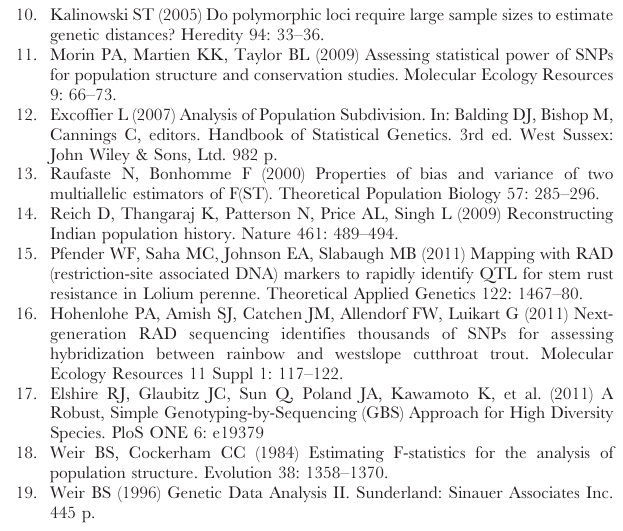
Figure S2 Effect of increasing sample sizes and increas- ing marker numbers for MAF . 0.25. Results are shown for the simulations where allele frequencies were equally distributed from 0.05 to 0.95. The number of markers was fixed at k = 100 (left column) and k =1,000 (left middle column). The number of individuals was fixed at n= 4 (right middle column) and n= 20 (right column). Each row contains a different level of genetic differentiation (F ST = 0, 0.01, 0.05, 0.1, 0.2, 0.4). The results (average F ST and 95% CI) of each estimator are depicted in the different graphs: F STW (blue circles), F STC&W (purple squares) and F ST R (green triangles). The dashed red line indicates the actual F ST for the simulated population.